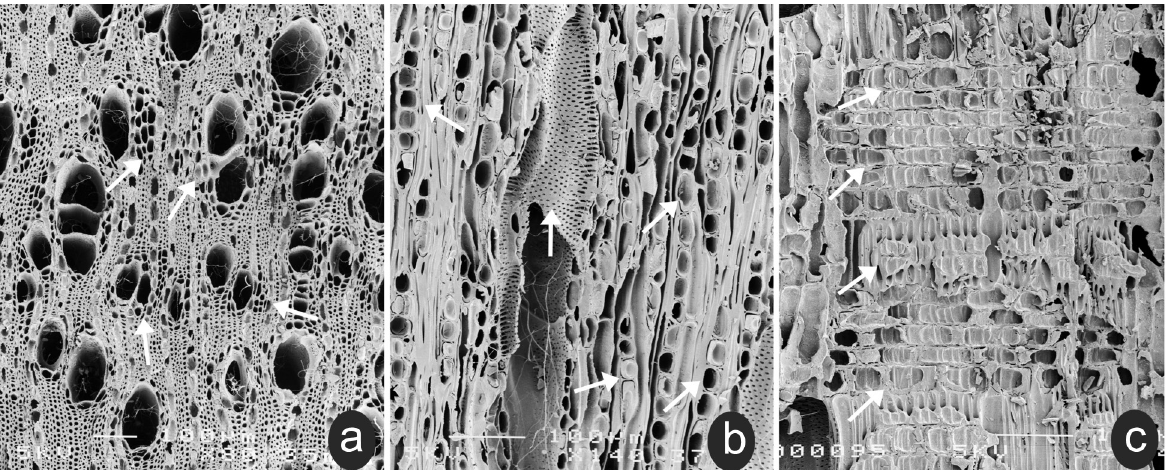
Figure 2. Terminalia glabrescens Mart. (Combretaceae / SPw 18). a: Transverse section [arrows: axial parenchyma]. – b: Tangential section [arrows: uniseriate rays; alternate intervessel pits]. – c: Radial section [arrows: all ray cells upright or square]. Bars = 100